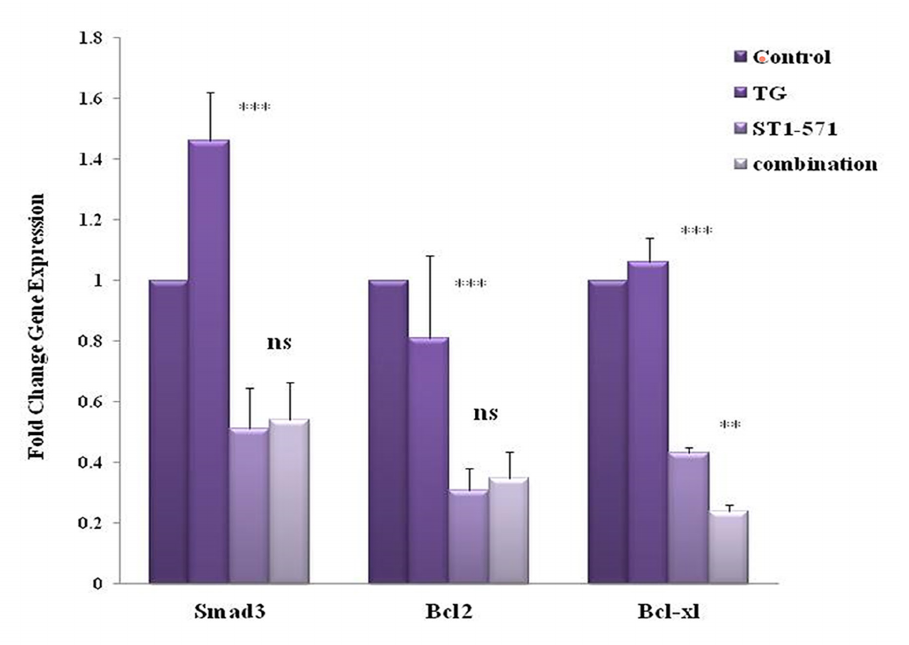
Figure 5: Fold changes in SMAD3, Bcl-2, and bcl-xL gene expression measured by Real-Time PCR. The results showed no significant differences between SMAD3 gene expression in cells treated with 0.5 µM STI-571, individually or in combination with 2 ng/mL TGF-β1, for 48 h. Cells in the STI-571-treated group showed significantly weaker induction Bcl-2 gene expression than cells in the control group. K562 cells treated with the combination of 0.5 µM STI-571 and 2ng/mL TGF-β1 showed a significantly lower level of Bcl-xL gene expression than cells treated with 0.5 µM STI-571 alone. The data are represented as mean ± SD. *** &** indicates P < 0.05, and “ns” stands for